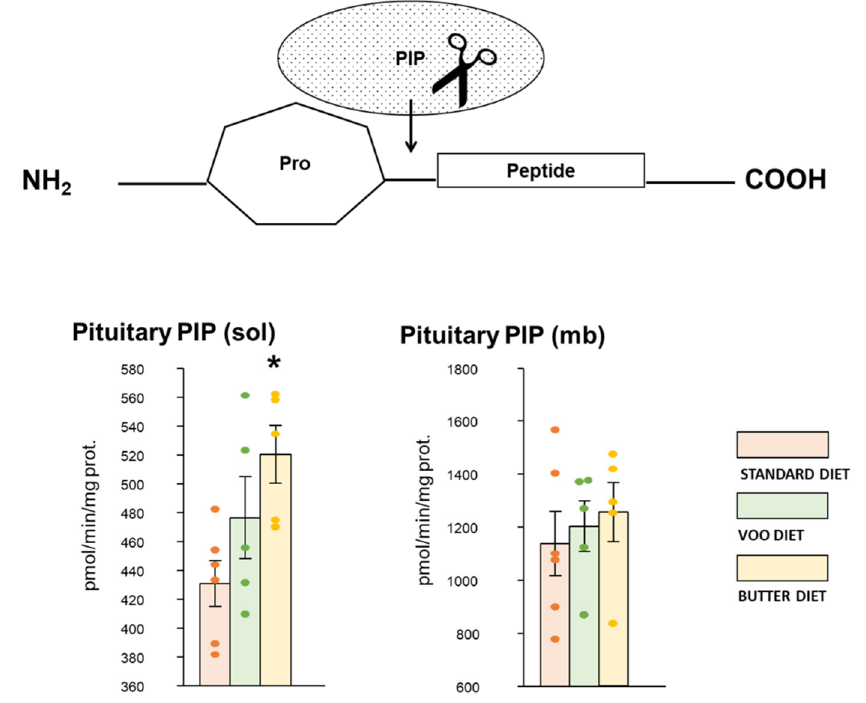
Figure 5. Proline-iminopeptidase (PIP) activity as neuromarker in pituitary, which cleaves the amino (NH2)-Proline (Pro) of peptide substrate. Mb: membrane-bound (mb) fraction; S: standard diet; Sol: soluble fraction; VOO: diet enriched with virgin olive oil; Bch: diet enriched with butter and cholesterol. The activities were expressed as picomoles of β -naphthylamide per minute per milligram of protein (pmol/min/mg prot.). * p -value < 0.05, compared to standard diet (S).